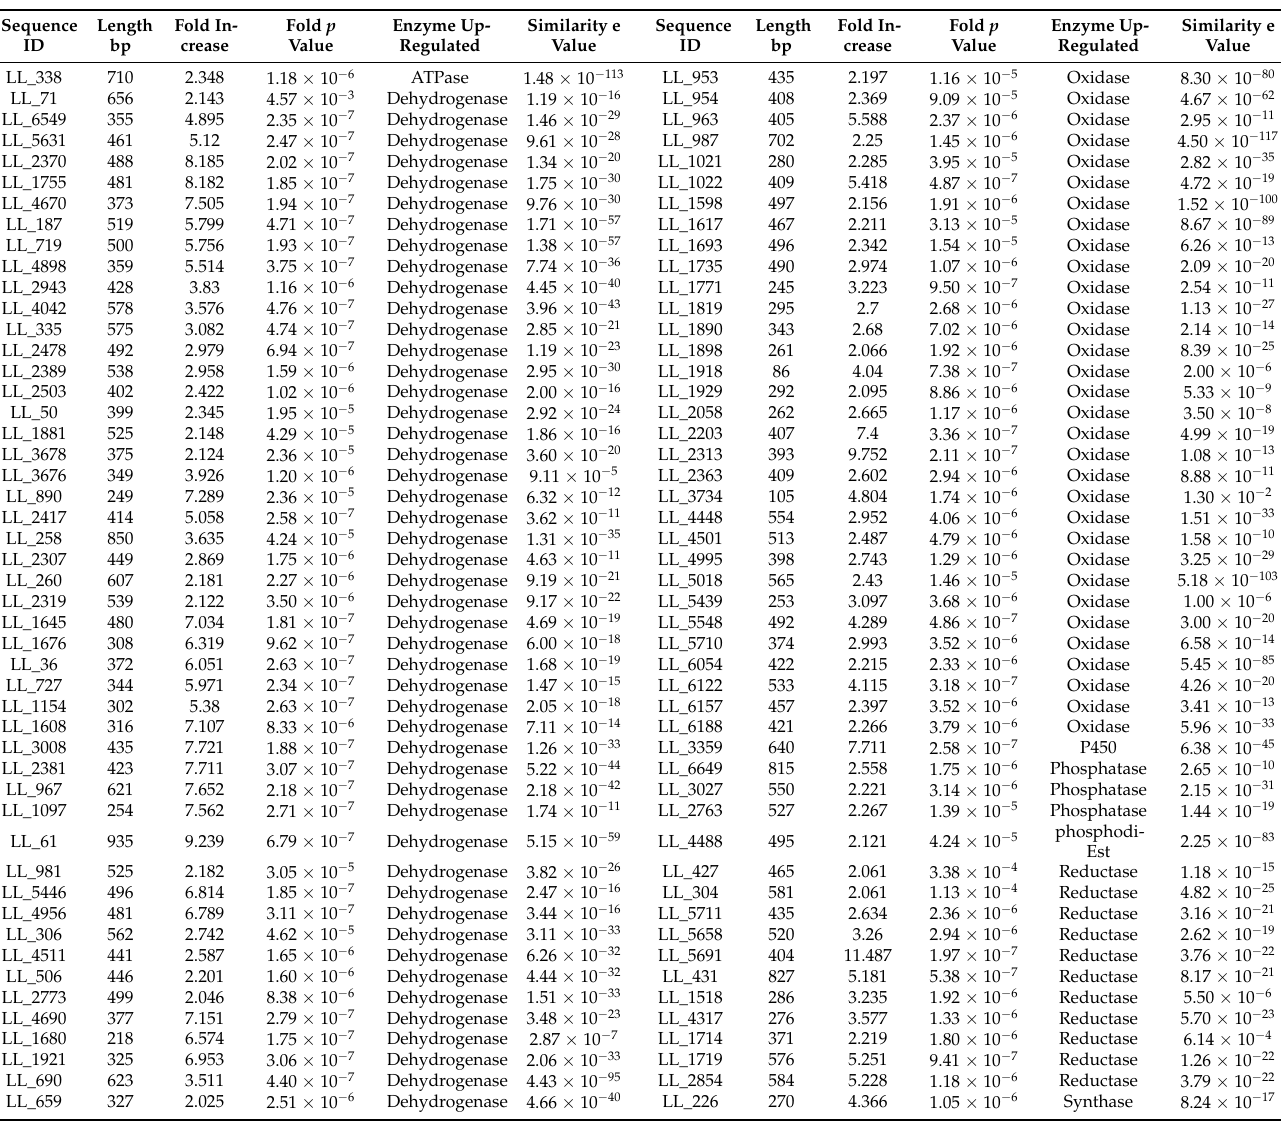
Table 1. Identification of 187 metabolic-enzyme-coding genes showing significantly up-regulated ( ≥ 2-fold) gene expressions in Arct2175FF resistant population using microarrays and analyzed with ArrayStar and Blat2go protocols (https://www.blast2go.com (accessed on 1 April